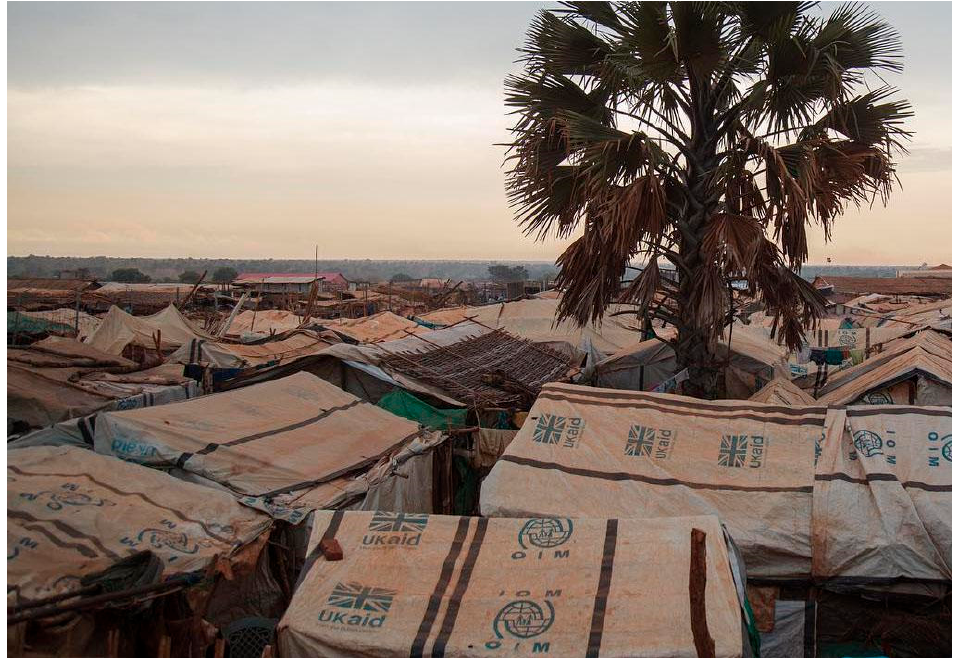
Figure 1. Traditional refugee camp design in Wau, Bahr el Ghazal, South Sudan Photograph taken by Bruno Feder, 2017.